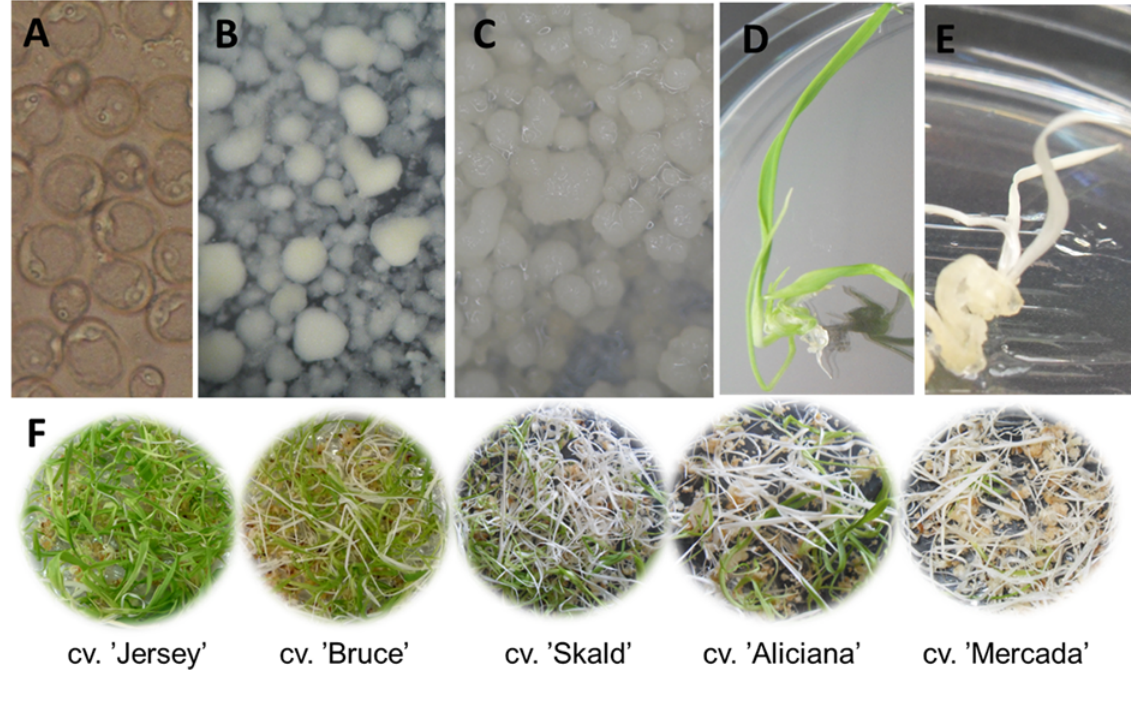
Figure 3 Development of embryos and regeneration of plants in isolated microspore culture of barley ( Hordeum vulgare L.). ( A ) Mid-to-late (ML) microspores aer isolation in mannitol solution. ( B ) Induced microspore-derived embryos on twenty-first day of in vitro culture. ( C ) Differentiating embryos on thirty-fih day of in vitro culture. ( D,E ) Regenerating green ( D ) and albino ( E ) plantlets. ( F ) Representative regeneration dishes of five barley genotypes presenting: 90%–70% (‘Jersey,’ ‘Bruce’), ca. 50% (‘Skald,’ ‘KWS Aliciana’), and 5% of green regenerants